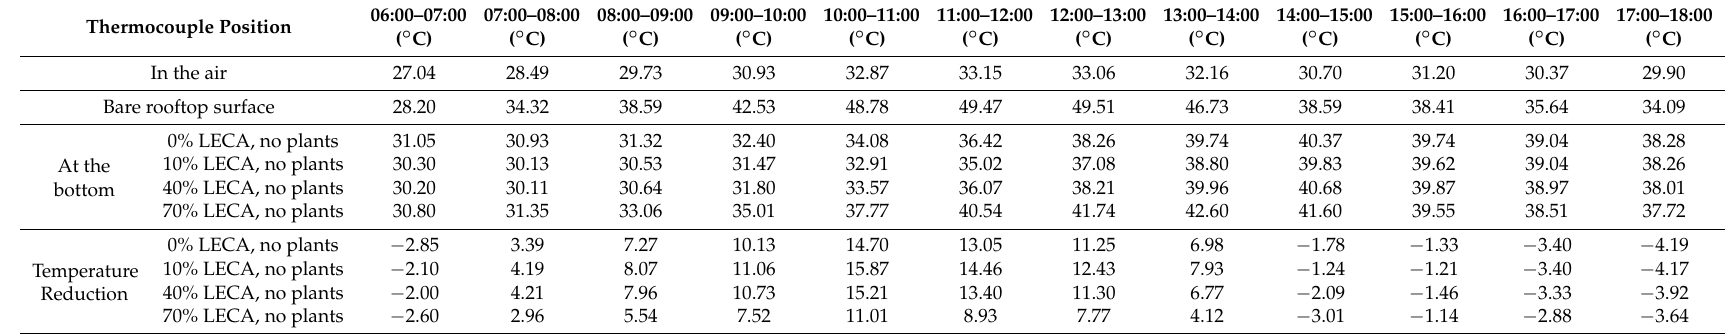
Table 6. Temperature at the bottom of the extensive roofs and temperature reductions in the cases of the extensive roofs with 0%, 10%, 40%, and 70% LECA laid at the bottom without plants (25 July 2017 06:00:09 to 25 July 2017 17:50:09). Thermocouple